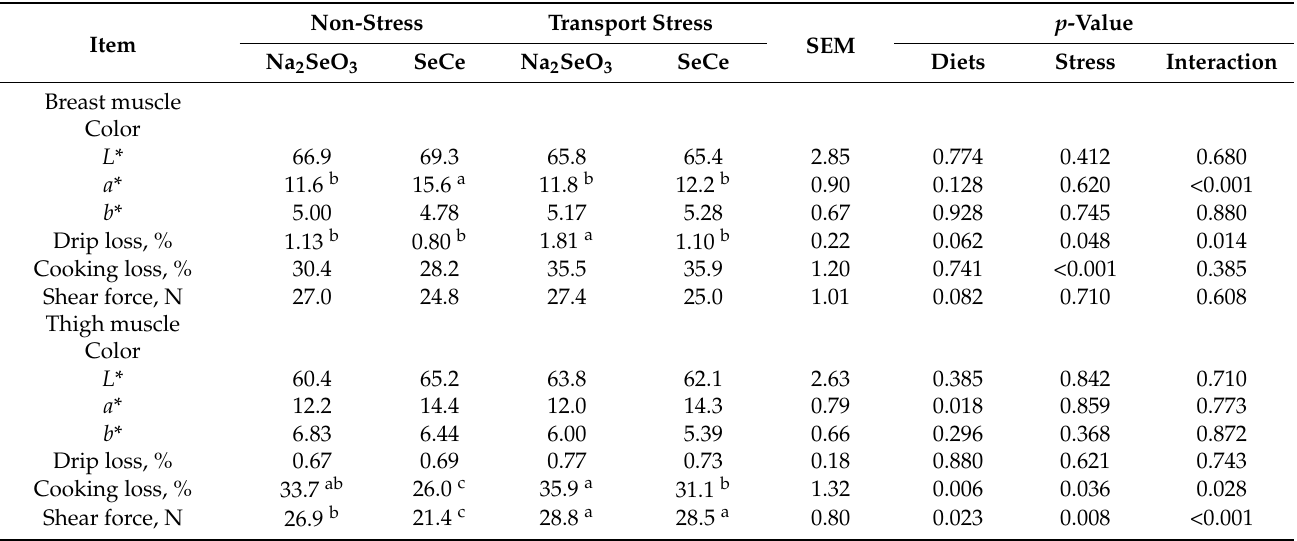
Table 5. Effects of dietary Se-enriched Cardamine enshiensis supplementation on meat quality of breast and thigh muscle in broilers under transport stress 1